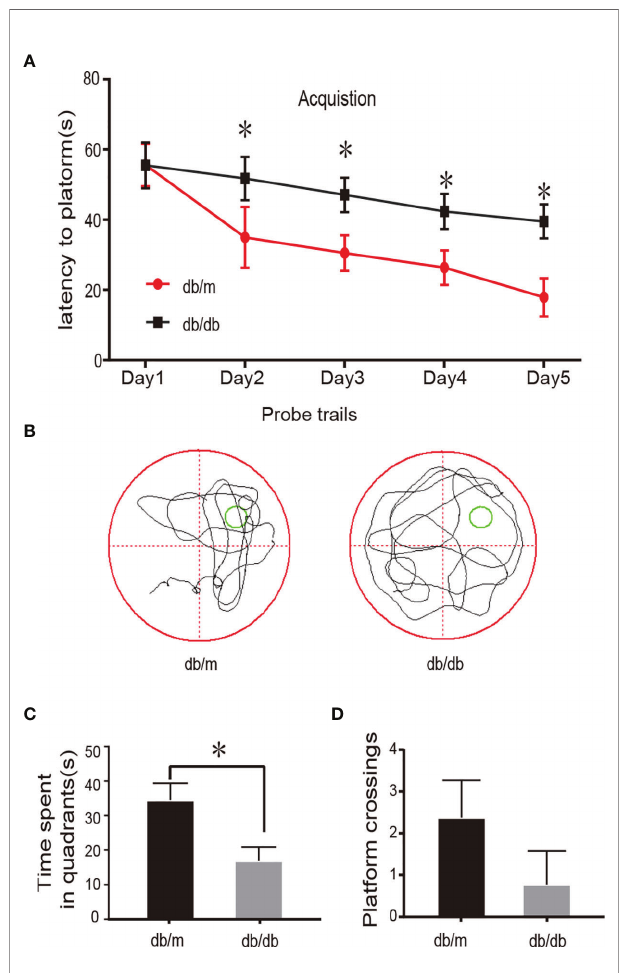
FIGURE 1 | Learning and memory impairment in db/db mouse. In the MWM test, day 1 represents performance on the fi rst trial, and subsequent scores show average of all daily trials. (A) Escape latency of the 5-day acquisition trials in MWM. (B) Representative swim pathways of respective groups in the spatial probe test. (C) Time spent in the target quadrant during the probe trial. (D) The numbers of the target platform crossings in the probe trial. Data are represented mean ± SEM for 3 mice in each group. ⁎ P < 0.05 vs. db/m